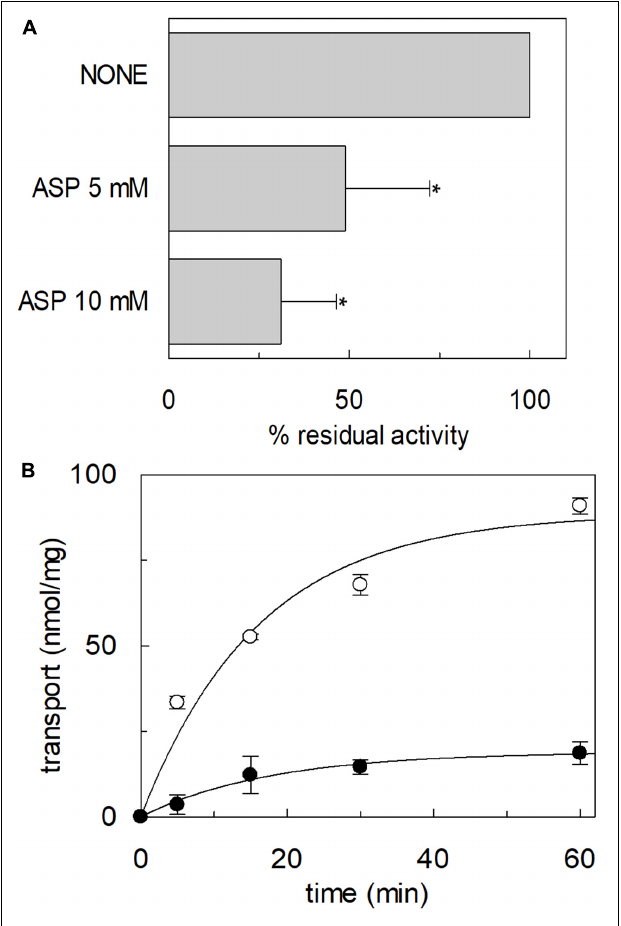
FIGURE 12 | Interaction of hASCT2 reconstituted in proteoliposomes with aspartate. Purified hASCT2 was reconstituted in proteoliposomes containing 10 mM glutamine as described in materials and methods. In (A) , inhibition by aspartate of the glutamate transport by ASCT2 reconstituted in proteoliposomes. The transport assay was started by adding 500 µ M [ 3 H]glutamate together with 50 mM Na-gluconate to proteoliposomes in the presence of indicated concentrations of aspartate. The transport was measured in 60 min according to the stop inhibitor method. The transport was indicated as % residual activity with respect to the condition with no external addition (none). Results are means ± SD from four independent experiments. *Significantly different from the control sample (none) as estimated by Student’s t -test ( P < 0.05). In (B) , uptake of glutamate and aspartate by ASCT2 in proteoliposomes. The transport assay was started by adding 500 µ M [ 3 H]glutamate ( ◦ ) or 500 µ M [ 3 H]aspartate ( • ) together with 50 mM Na-gluconate to proteoliposomes. The transport was stopped at the indicated times according to the stop inhibitor method. Data were plotted with the first-order rate equation. Results are means ± SD from three independent experiments.